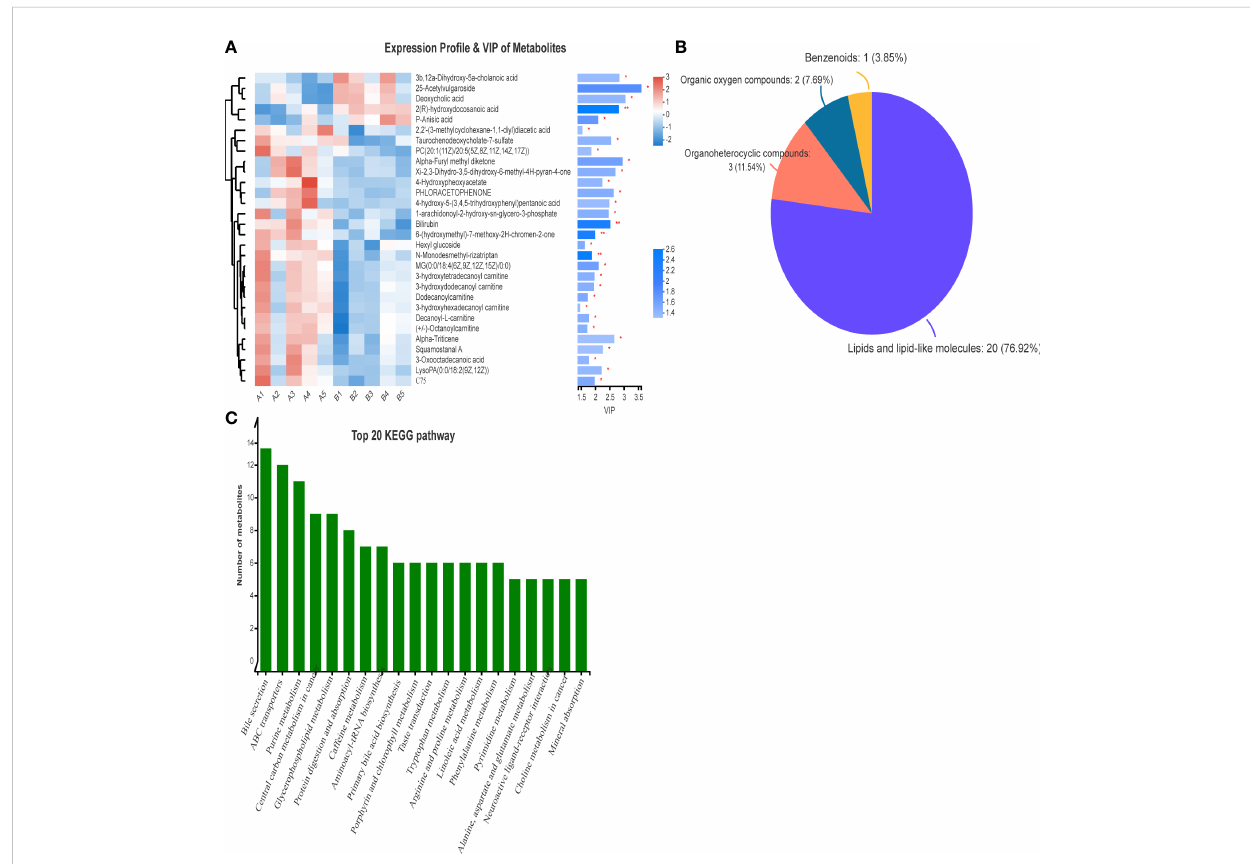
FIGURE 6 VIP analysis and HMDB compound classi fi cation of serum metabolomics before and after FMT. (A) VIP analysis of serum metabolomics before and after FMT. (B) Compound classi fi cation map of serum metabolomics before and after FMT. (C) KEGG pathway analysis of serum metabolomics in patients before and after